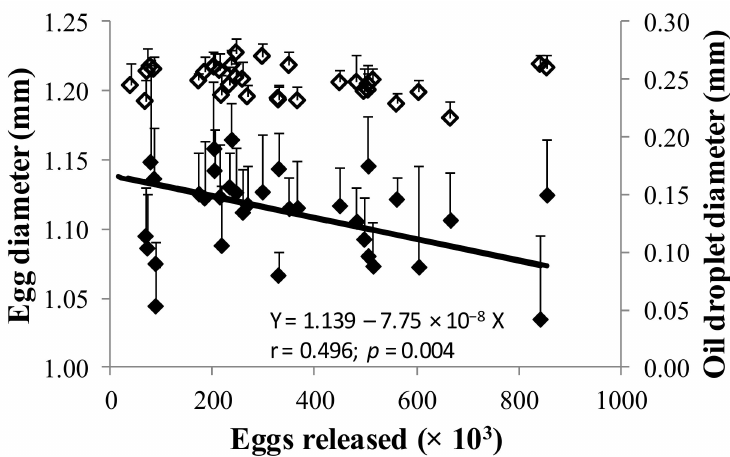
Figure 8. Egg diameter (black rhombus) and oil droplet diameter (white rhombus) in relation to number of eggs produced at different days of the monitoring period. Data show mean ±